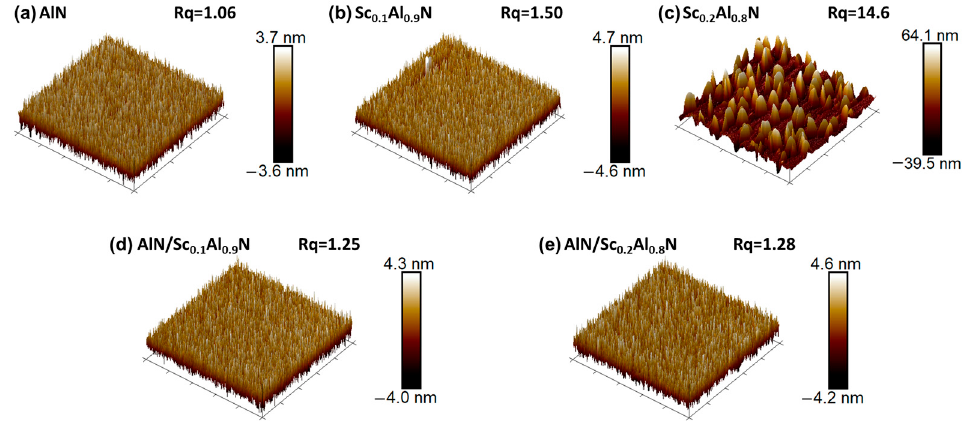
Figure 4. The AFM of ( a ) AlN, ( b ) Sc 0.1 Al 0.9 N, ( c ) Sc 0.2 Al 0.8 N, ( d ) AlN/Sc 0.1 Al 0.9 N, and ( e ) AlN/Sc 0.2 Al 0.8 N films.